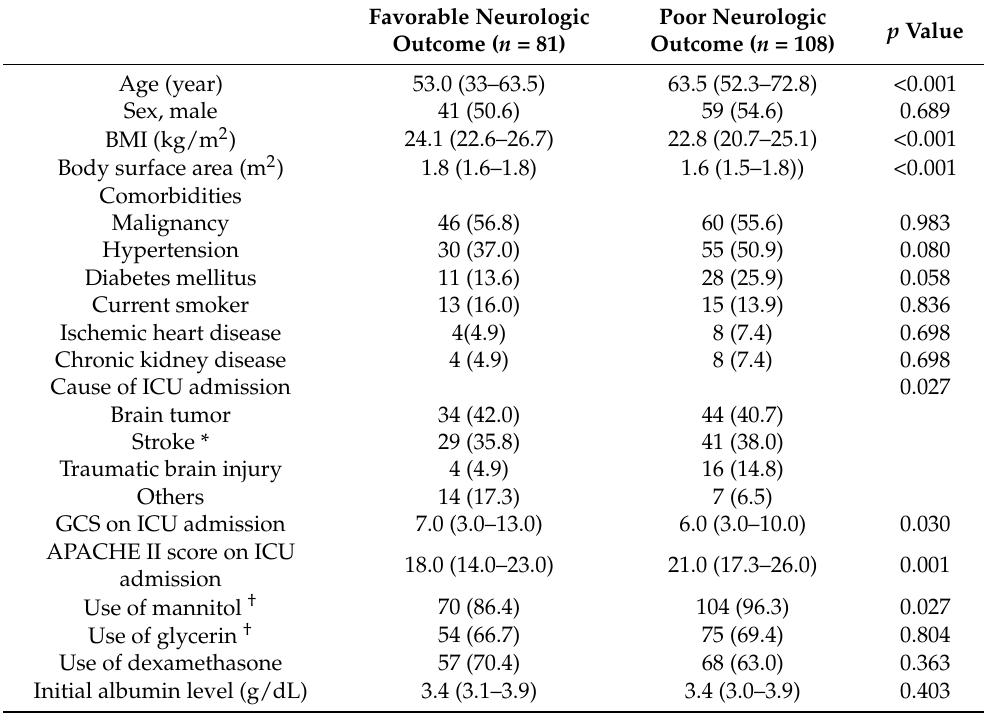
Table 1. Baseline